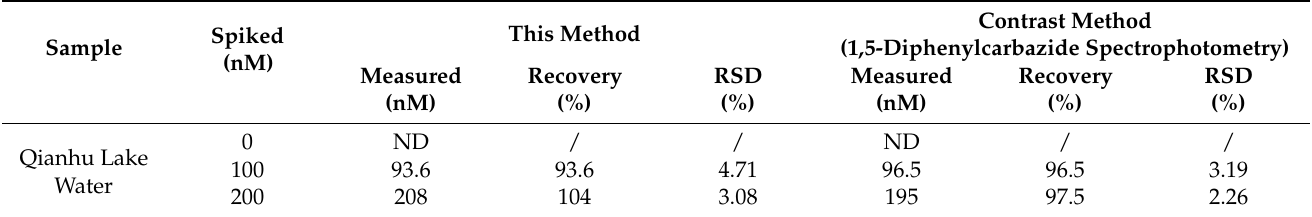
Table 2. The detection of Cr(VI) in Qianhu lake water and the spiked assay results ( n = 3).